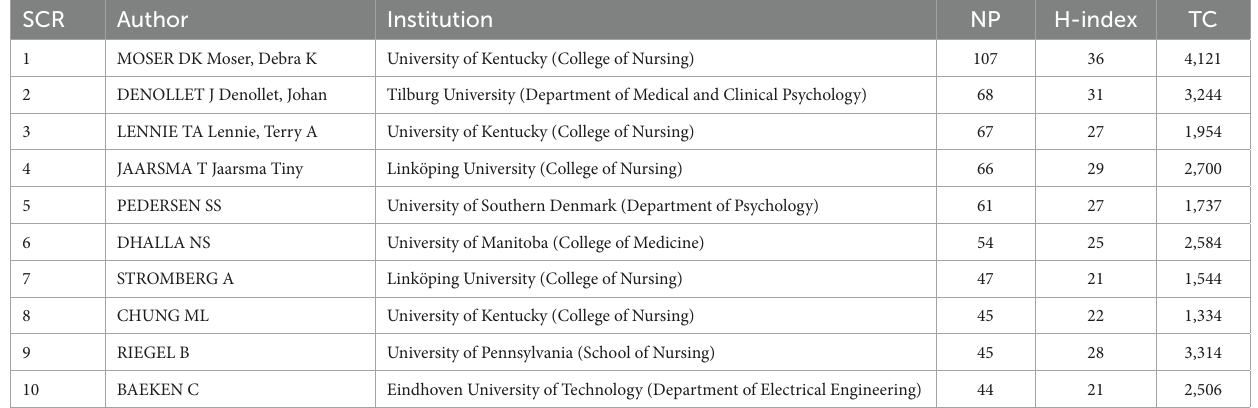
TABLE 3 Top 10 most productive authors contributing to research related to heart failure and depression.